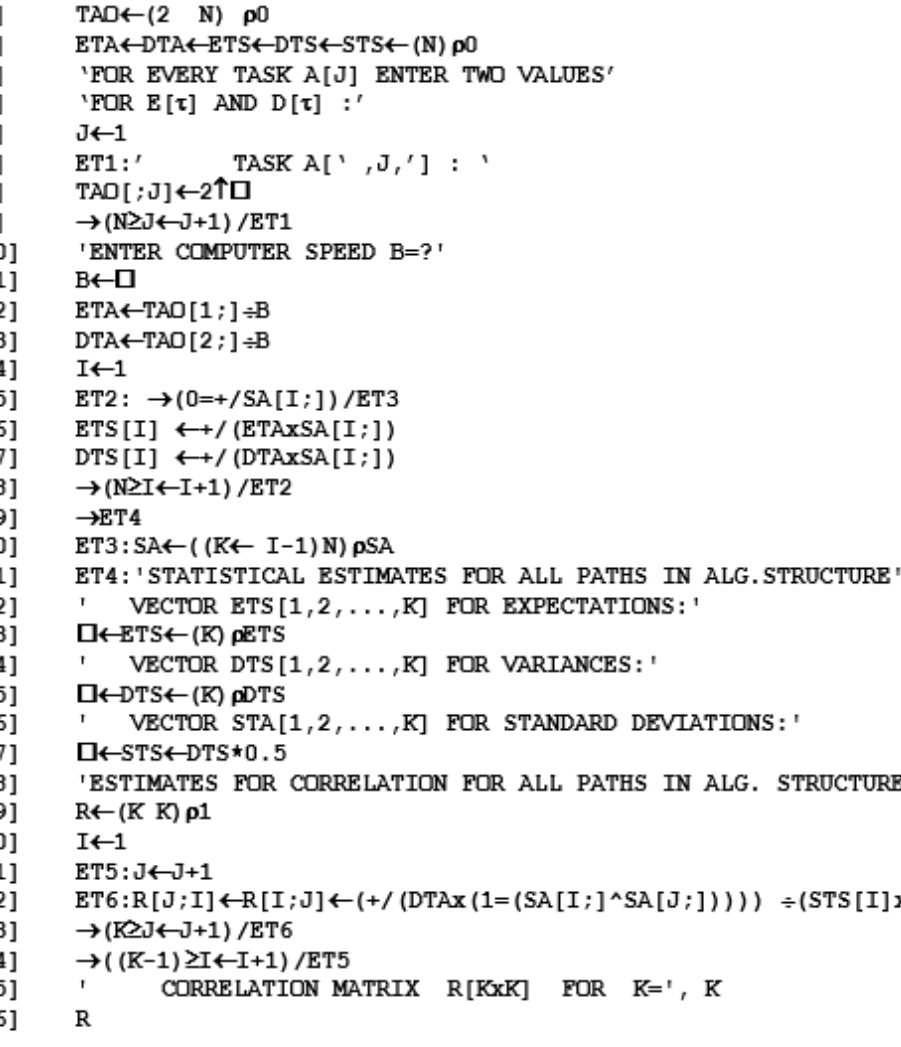
Figure 4. Program function ‘ESTIMATES’.